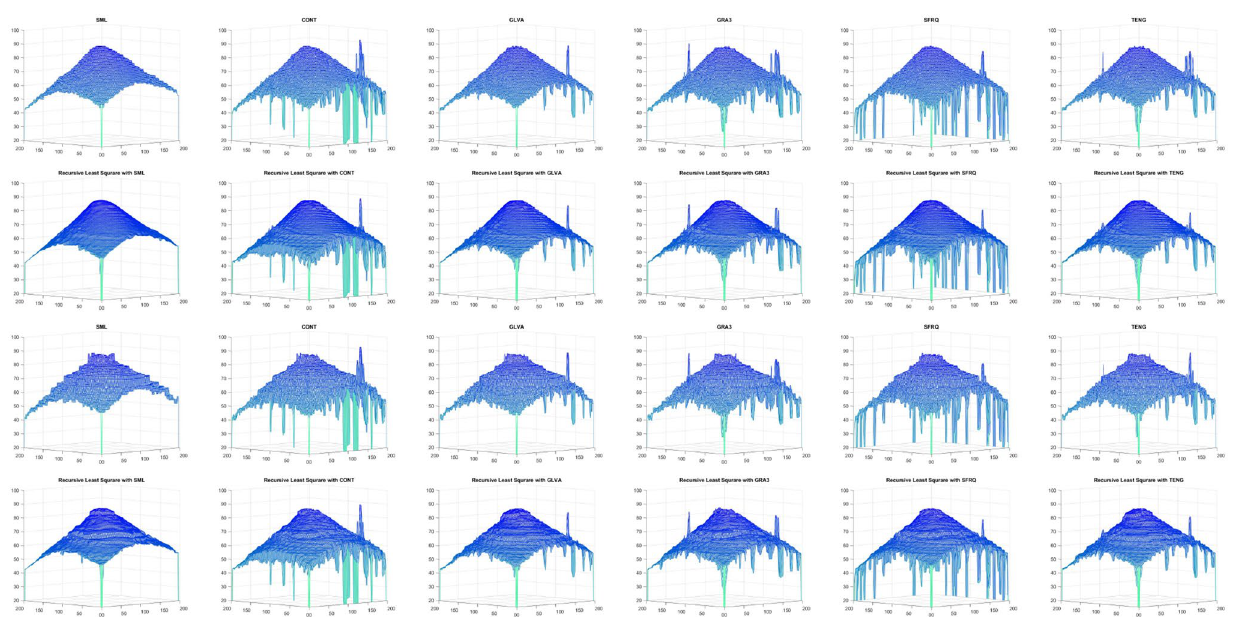
Figure 11. Shape reconstruction of real cone using FM with proposed RLS method with Jitter noise b ) 2 σ 2 2 a 2 σ 4 σ 2 ( 2 ak ξ = ζ + ζ . (left to right), SML, CONT, GLVA, GRA3,SFRQ, TENG. (top row) with FM + 0 , (second row) using FM with RLS method σ 2 0 , (third row) with FM only with σ 2 only with σ 2 ζ ζ = = 1.5 (bottom row) using FM with RLS method σ 2 ζ =